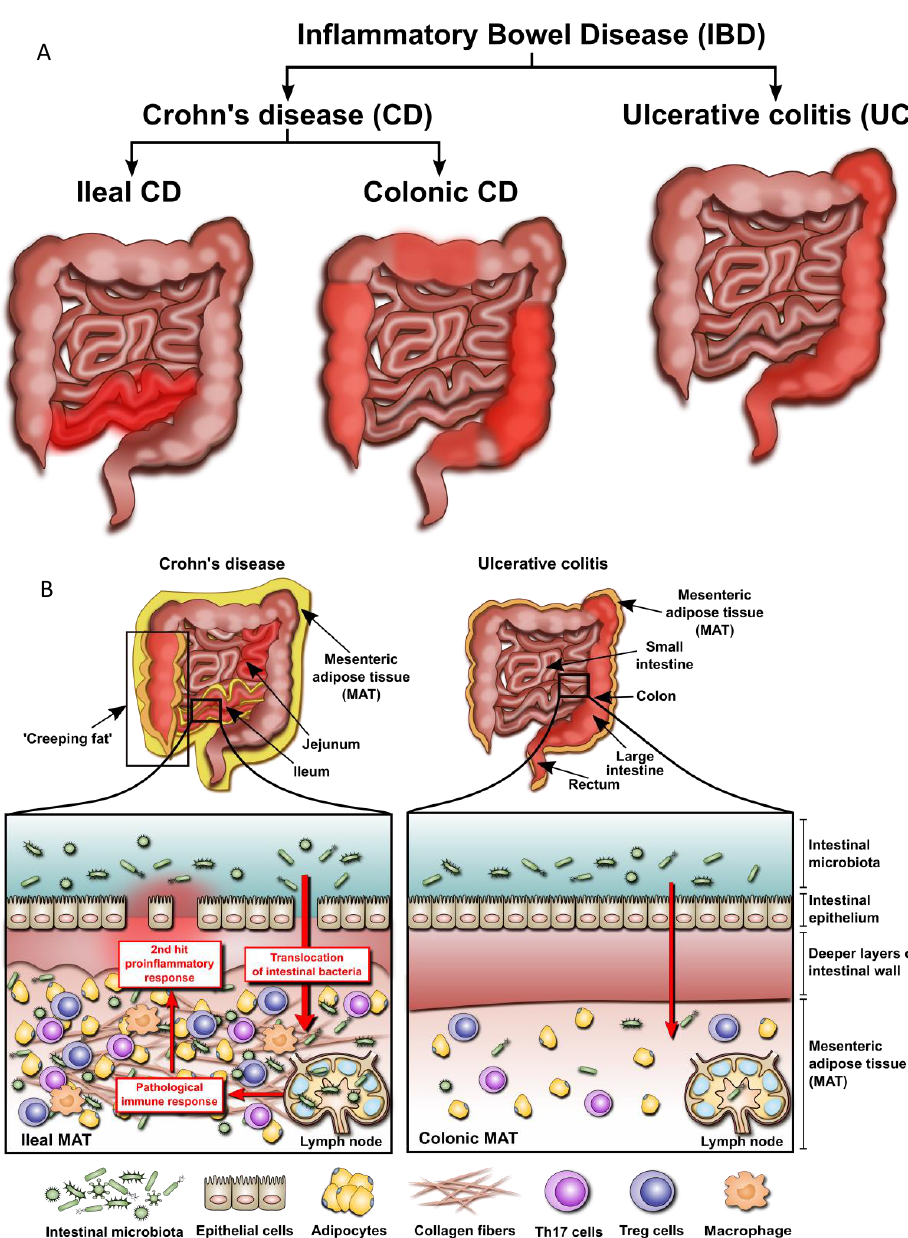
Figure 3. ( A ) Location of lesions in di ff erent forms of IBD. ( B ) Postulated di ff erences in the involvement of mesenteric adipose tissue in IBD with ileal and colonic lesions. Ileal inflammation compromises the integrity of the intestinal epithelial barrier leading to translocation of altered intestinal microbiota into mesenteric fat and lymph nodes. Interaction of adipocytes with gut bacteria results in adipocyte hyperplasia, induction of proinflammatory genes and secretion of chemokines attracting various leukocyte populations. The accumulation of pathogenic bacterial species in mesenteric lymph nodes drives the immune response resulting in persistent inflammation in the mesenteric adipose tissue. This aggravates the destruction to the adjacent ileal wall, which further impairs the intestinal barrier and allowsmoregutbacteriatotranslocatetothemesentery. Theresulting“viciouscircle”fuelsinflammation and leads to fibrosis. The translocation of intestinal microbiota during colonic inflammation appears to be less pronounced leading to only a moderate exposure of the mesentery to bacteria. As a result, adipocytes do not significantly amplify the inflammatory response so that there is no additional “hit” to damage the intestinal